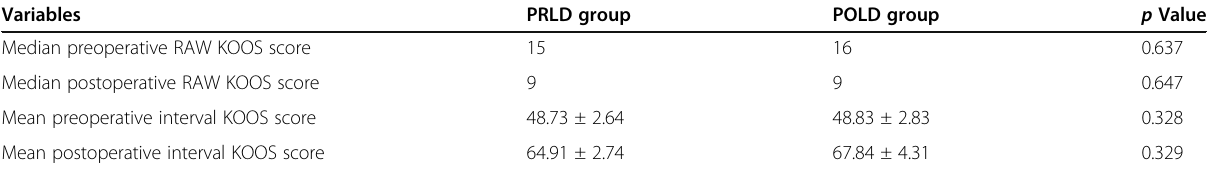
Table 2 Intergroup comparison of pre- and postoperative KOOS Jr. score